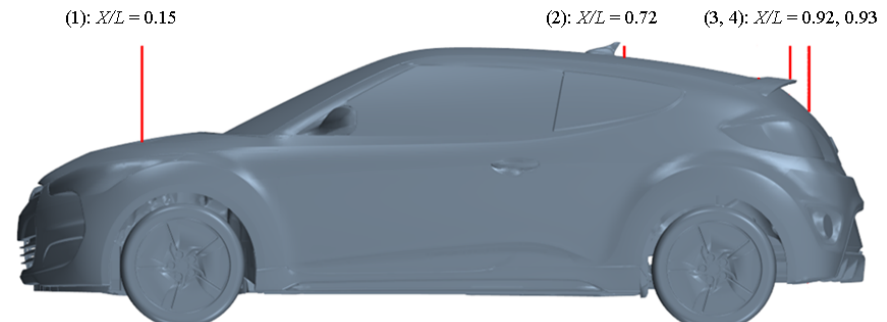
Figure 15. Four selected lines (on the central plane of the vehicle) for quantitative analysis inside the boundary layer. Note that the four red lines only represent the location, not the actual length.